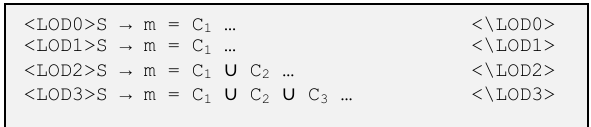
Figure 4. Original production rules of S.